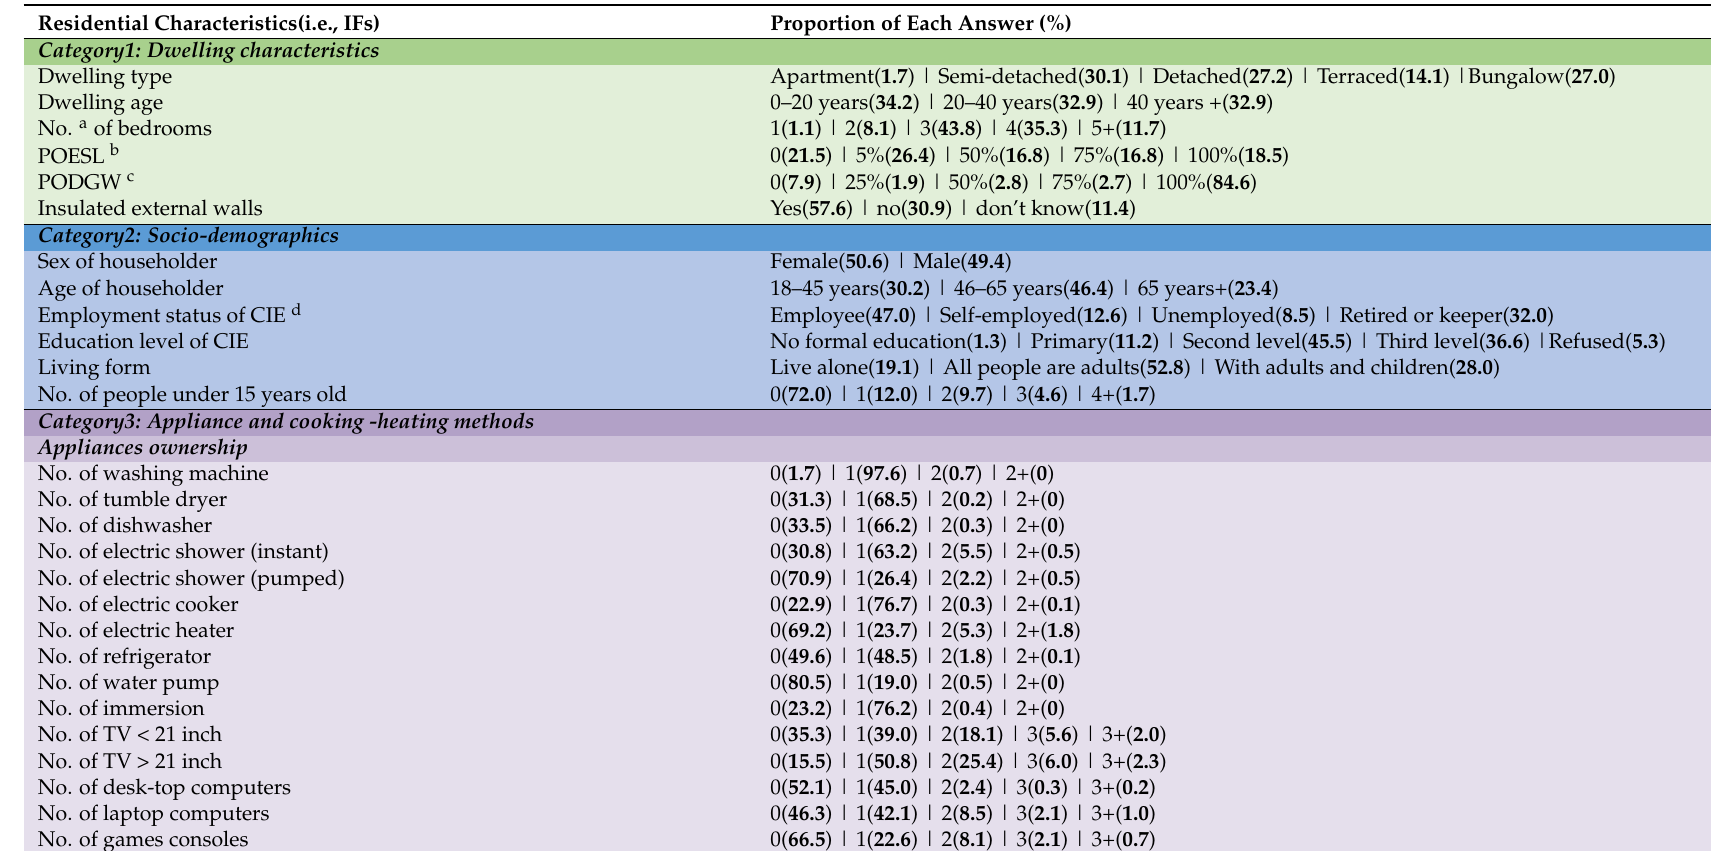
Table 1. Overview of residential characteristics in survey